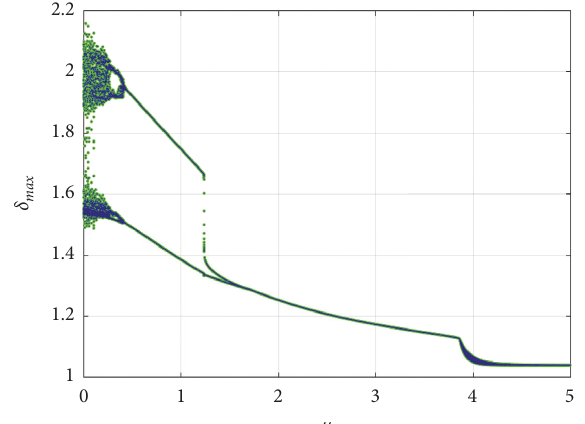
Figure 11: Bifurcation diagram for the controlled fractional-order power system (31) by varying the coupling strength parameter μ .